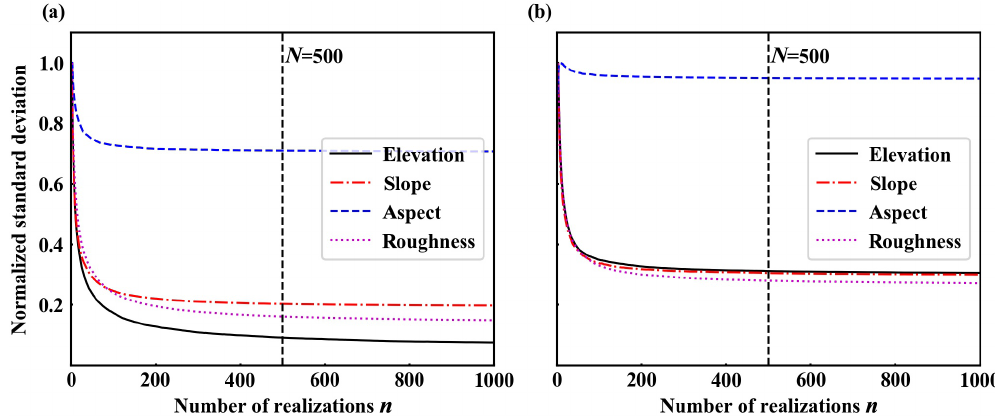
Figure 5. The relative change in topographic attributes with respect to the number of HK-DTM realizations. The realizations are generated with (a) USS N {RMSE = 3 . 3, d = 180}; (b) CSS N . Beyond N = 500, adding more realizations has little impact on topographic attributes. Therefore, we set N = 500 for all computational scenarios in Table 1.